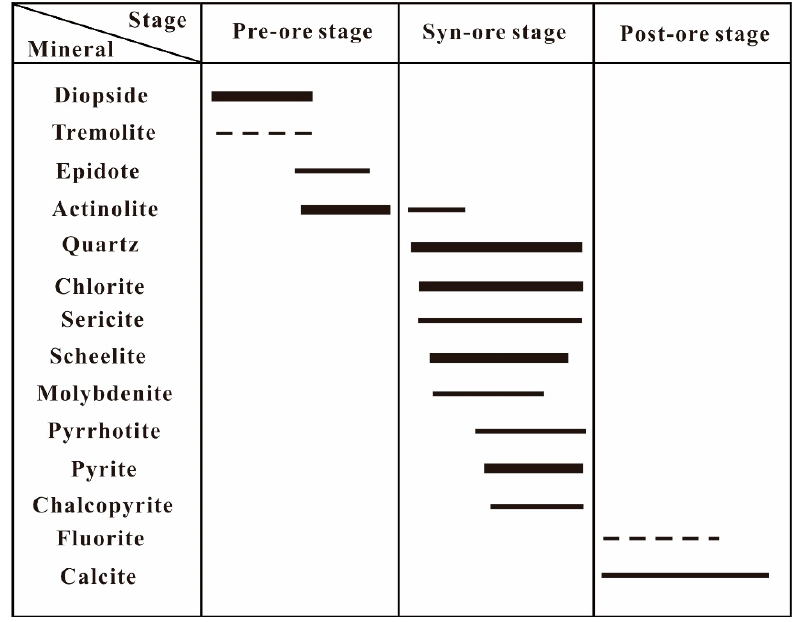
Figure 4. Reflected ‐ and transmitted ‐ light photomicrographs showing the typical morphology and textures of ore and gangue minerals in the Shangfang W deposit. ( a ) diopside and tremolite coexist in the early stage; ( b ) the diopside was altered to actinolite; ( c ) actinolite coexists with the early ‐ stage scheelite; ( d ) chloritization and silicification; ( e ) Sericite alternated from plagioclase; ( f ) chlorite alternated from amphibole; ( g – h ) the scheelite coexists with massive pyrrhotite, chalcopyrite and minor molybdenite; ( i ) calcite and fluorite. Abbreviations: Di = Diopside; Tr = Tremolite; Act = Actinolite; Sch =Scheelite; Qtz = quartz; Ser = sericite; Po = Pyrrhotite; Chl = Chlorite; Mo=molybdenite; Clp = Chalcopyrite; Cal = calcite; Fl = fluorite.